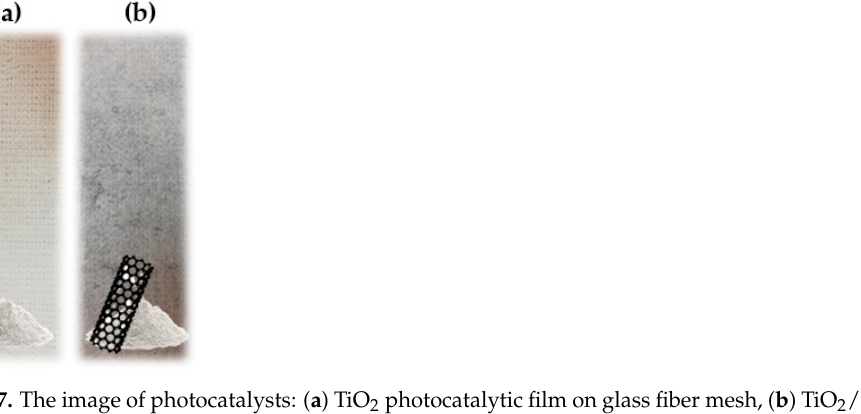
Figure 8. The set up for the CPC reactor. (1) Solution mixing and sampling; (2) Peristaltic pump; (3) Irradiation source; (4) CPC reactor. As an irradiation source, a custom-made panel with three full spectra lamps (JBL, Neuhofen, Germany, Solar Ultra linear fluorescent lamps: Color, Tropic and Nature, T5, 145 cm, nominal power 80 W) and corresponding reflective mirrors (JBL, Neuhofen, Ger- many, Solar Reflect 146) was used. The UVB and UVA intensities were determined at the lamp wall (I w ) by UVX radiometer (UVP Products, Analytik Jena US LLC, Upland, CA) fitted with corresponding longwave UV-A UVX-36 (range 335–385 nm) and midrange UV-B UVX-31 (range 280–340 nm) sensors of ± 5% accuracy (Figure 9). The CPC reactor